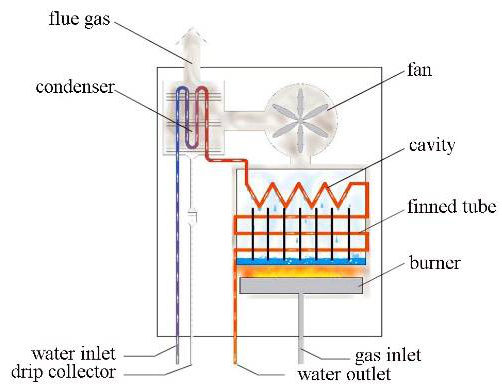
Figure 4. Working process of the new gas heat exchanger with addition of condenser.